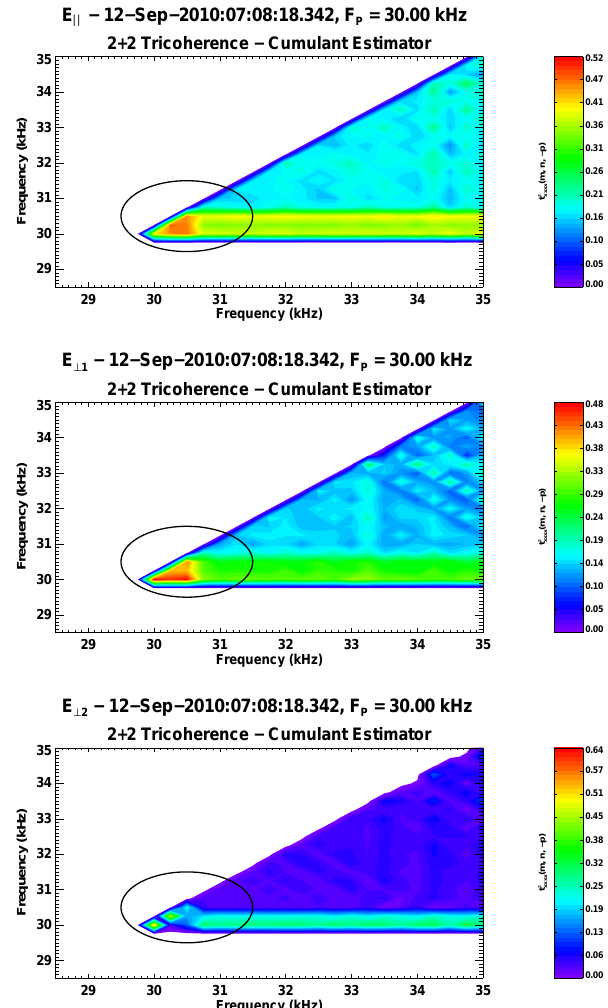
Fig. 6. The tricoherence spectra t 2 (F k ,F l ,F p ) of the parallel and perpendicular components of the wave packet. The tricoherences t 2 exhibit peak values of ∼ 0 . 6, ∼ 0 . 45 and ∼ 0 . 4 at ( ∼ 30 . 5, ∼ 30, ∼ 30)kHz, which quantifies the phase relation 2 φ L = φ D + φ U , where φ L , φ D and φ U are the phases of the beam-excited Lang- muir wave at ∼ 30kHz, Stokes ( ∼ 29 . 5kHz) and anti-Stokes ( ∼ 30 . 5kHz) modes, respectively